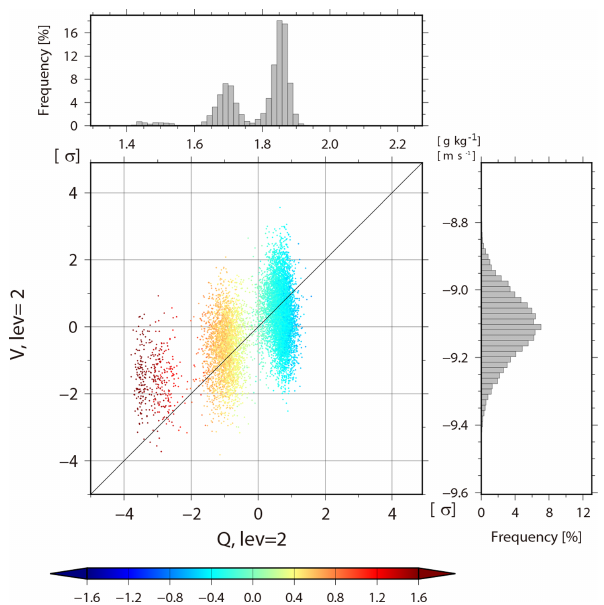
Figure 16. Similar to Fig. 14, but for background specific humidity versus meridional wind background at the second level ( ∼